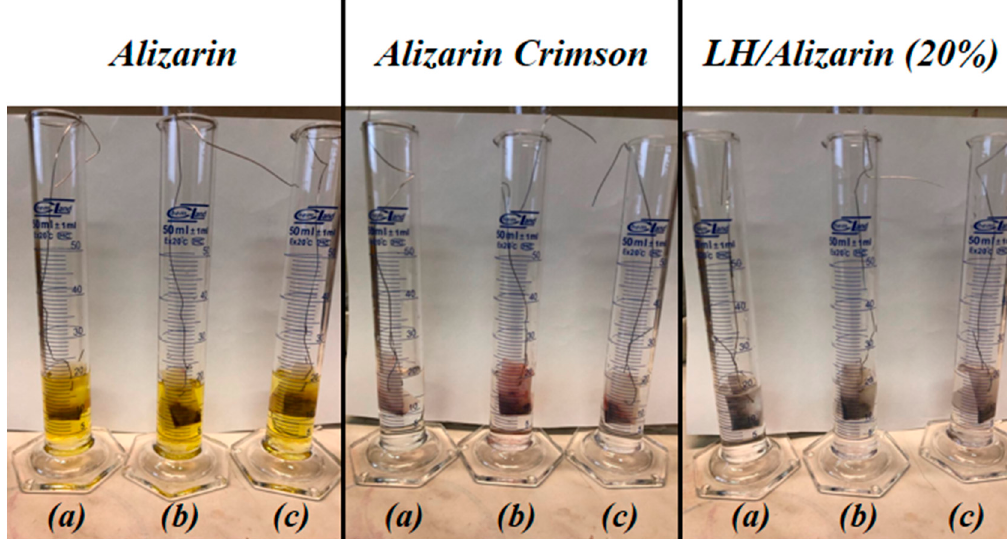
Figure 11. Digital images of alizarin, Alizarin Crimson, and alizarin pigments after 24 h of immersion in toluene (a) , acetone ( b ), and ethyl alcohol ( c ).